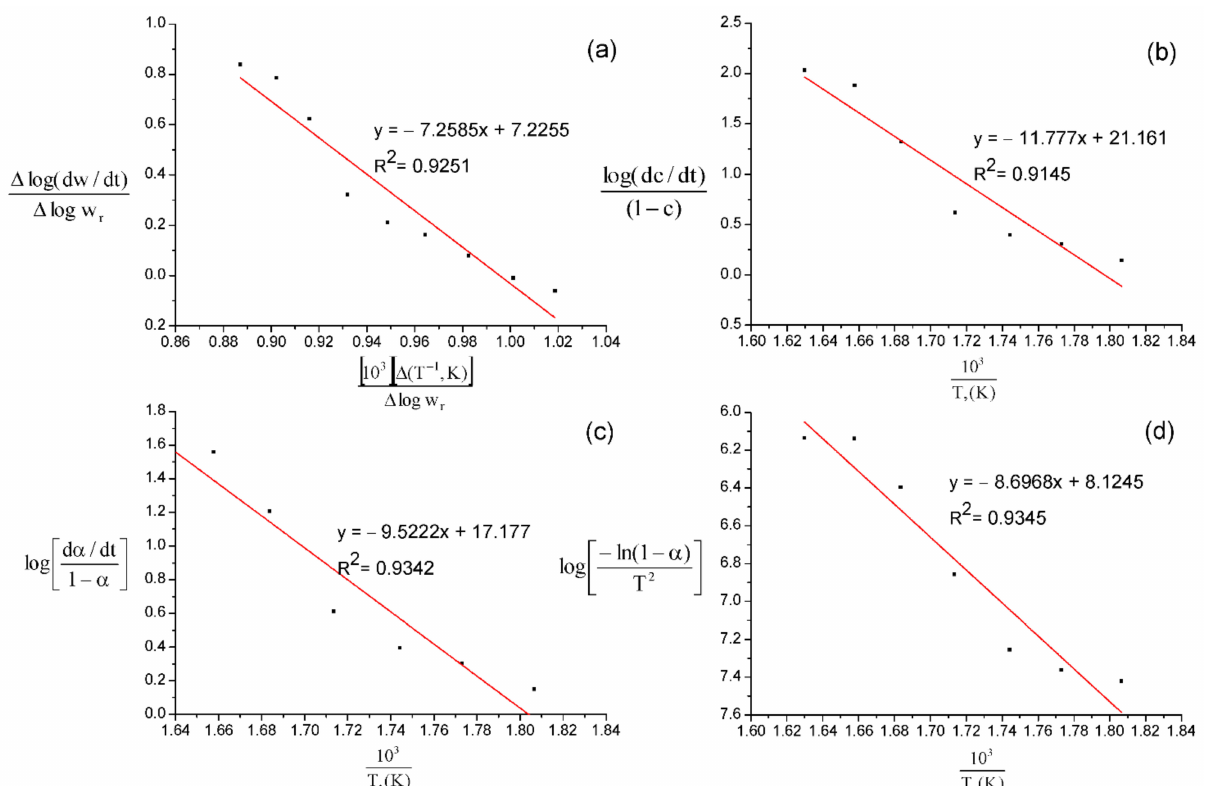
Figure 18. Processing of TGA anabasine- β CD 1:1 data by Freeman–Carroll ( a ), Sharpe–Wentworth ( b ), Ahar ( c ), and Coates–Redfern ( d ) methods. Table 2. Kinetic parameters of thermal destruction were obtained by processing the data of